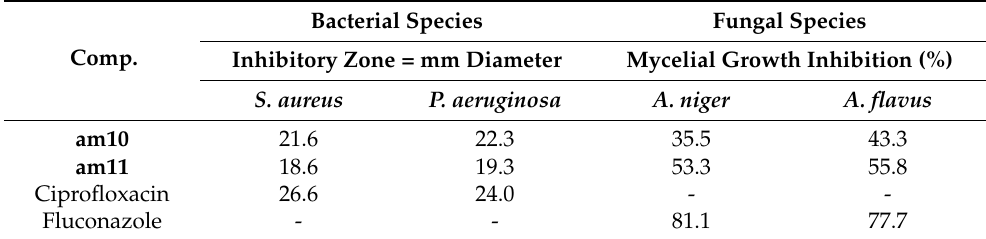
Fluconazole Alagawadi et al. derived a sequence of TZD analogues containing the